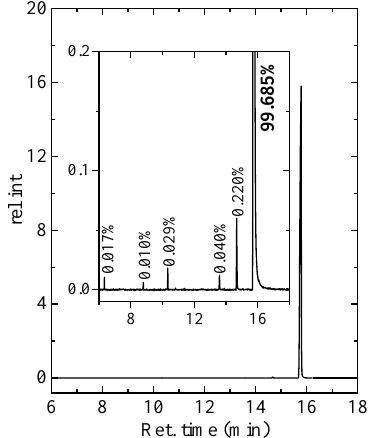
Figure 1. Gas chromatography mass spectrometry (GC-MS) chromatogram of C 23 H 48